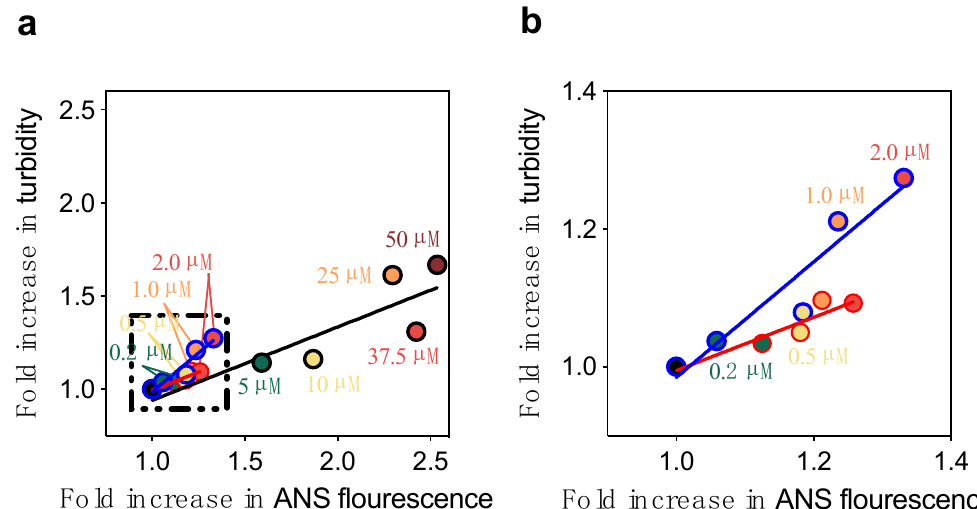
Figure 7. Size-hydrophobicity relationship for increasing concentrations of the designed antibodies and trodusquemine. ( a ) Linear fits between size and solvent-exposed hydrophobicity for increasing concentrations of DesAb 34-40 (blue line, slope = 0.84 ± 0.15, R = 0.95), DesAb 18-24 (red, slope = 0.38 ± 0.08, R = 0.86), and trodusquemine (TRO, black line, slope = 0.39 ± 0.12, R = 0.86). ( b ) Zoomed in view of panel a for the designed antibodies.